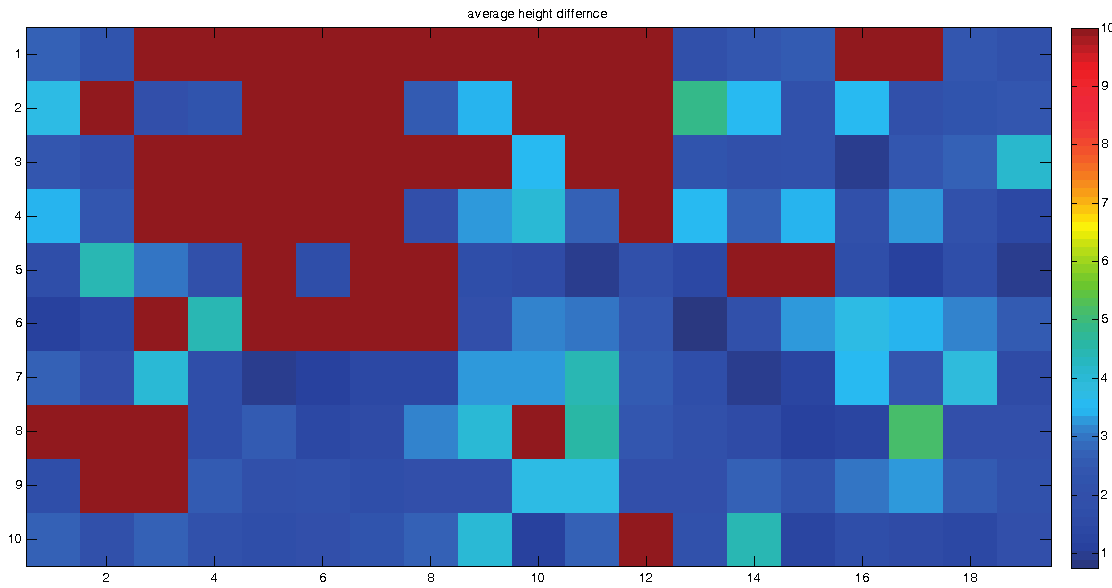
Figure 18. Change detection analysis: statistical estimators reflecting on ICP process reliability; number of point-coupling ( top ), Standard Deviation (SD) of height value difference ( middle ) and average height value difference ( bottom ). Last two values are in